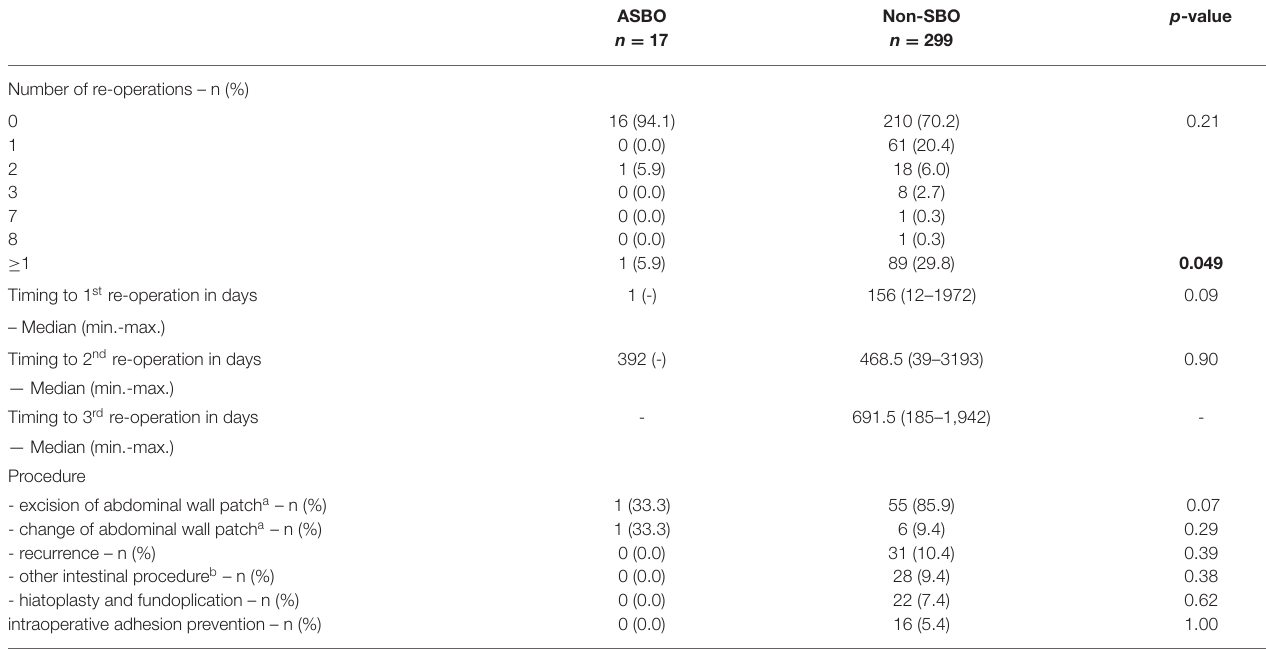
TABLE 9 | Re-operations during follow-up concerning patients with ASBO and non-SBO.